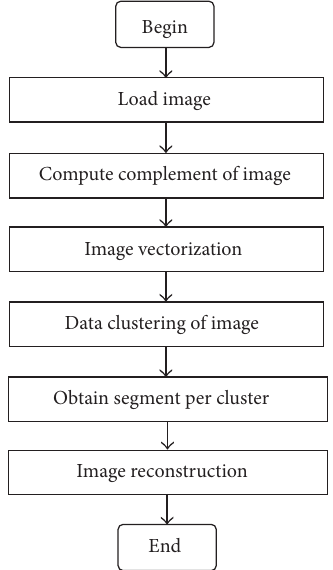
Figure 1: Block diagram for segmentation images using clustering algorithms.